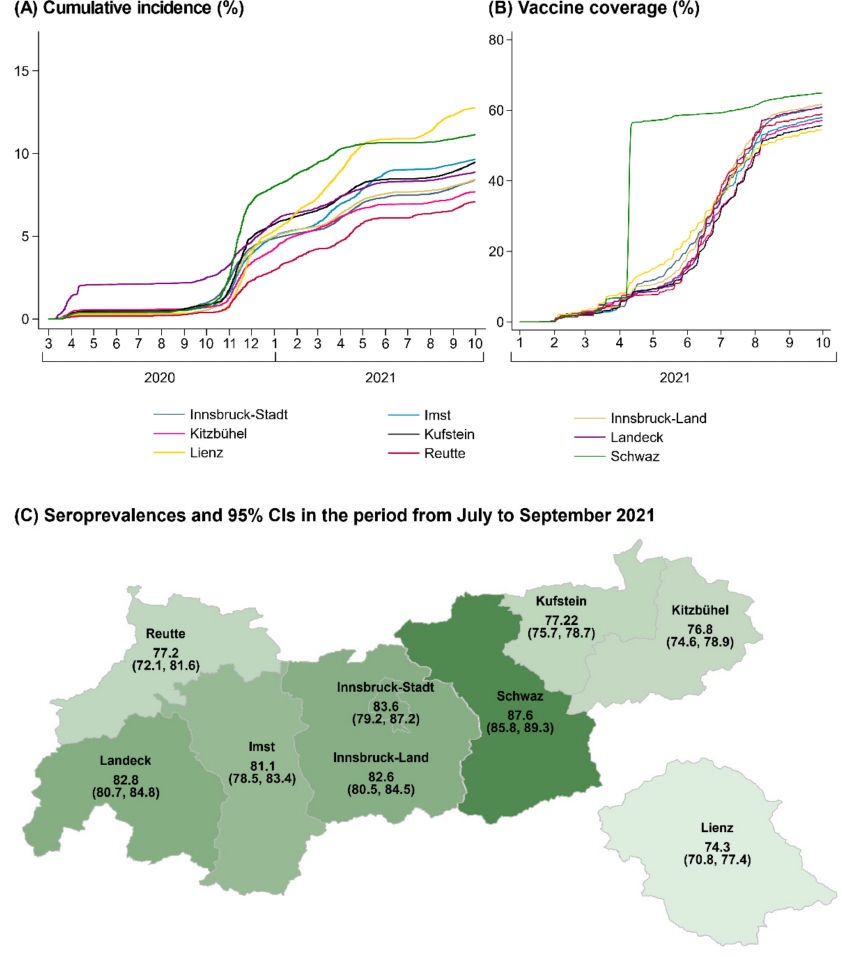
Figure 2. Regional differences in cumulative SARS-CoV-2 incidence and vaccine coverage in the total population of Tyrol (Panels A , B ) and seroprevalence of anti-S IgG antibodies in the blood donors